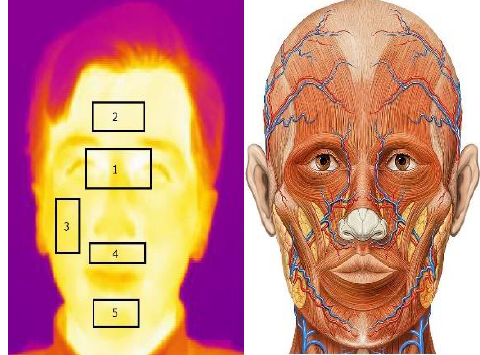
Figure 3. The five extracted regions of interest (ROI) from a face. These areas are most affected by emotional states because of the vascular anatomy of the face. These ROIs were used in previous studies in this field and the which of them has more information for psychophysiological monitoring is still controversial [34].